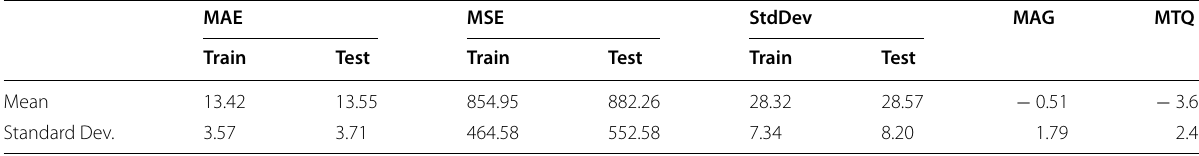
Table 1 Summarized residual and offset data over all available months for low‑ and mid‑latitudes. Errors and standard deviation given in nT, while the offsets for the magnetometers (MAG) and magnetorquers (MTQ) are given in seconds